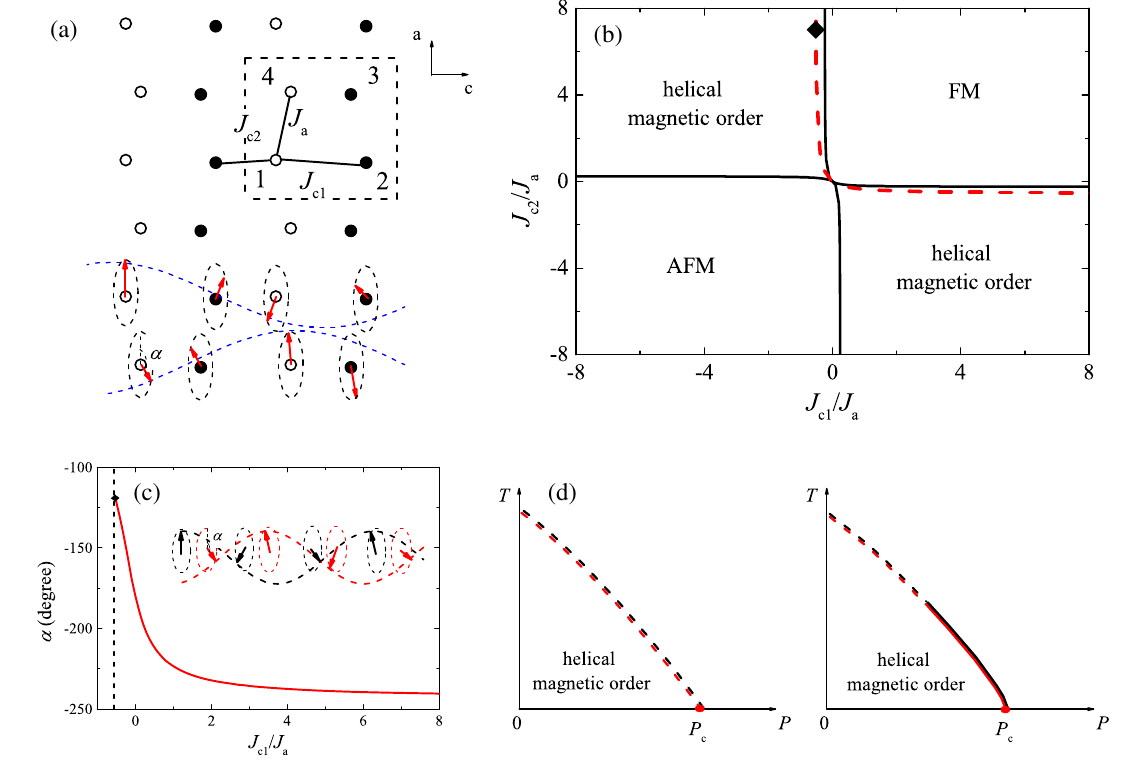
FIG. 7. Structure and magnetic phase diagram of CrAs. (a) Sketch of the CrAs lattice, with the b axis perpendicular to the paper plane. The open and closed symbols stand for the Cr atoms at layers b= 4 and 3 b= 4 , respectively. Each unit cell consists of four Cr atoms, labeled 1 through 4. The magnetic ground state is studied in a Heisenberg model [33] with exchange couplings up to fourth nearest- neighbor pairs of Cr, J , J , J , and J , where J (not shown) couples the magnetic moments of the same sublattice in nearest-neighbor a b c 1 c 2 b unit cells along the b axis. The arrows label the spin pattern associated with the double helical magnetic order. (b) Ground-state magnetic phase diagram of the model for CrAs. FM and AFM refer to ferromagnetic and antiferromagnetic states, respectively. The AFM state has an ordered wave vector Q ¼ ð 0 ; 0 ; 0 Þ , but the spins are staggered within each unit cell. The double helical magnetic order has a propagating wave vector Q ¼ ð 0 ; 0 ; δ Þ . The phase boundaries among the three phases are separated by two hyperbola, marked by solid curves. The red dashed line is a curve with fixed helical wave vector δ ¼ 0 . 353 · 2 π =c , and the diamond shows the position of the state with magnetic phase angle α ¼ − 120 °. (c) Evolution of the phase angle α for the double-helical order (illustrated in the inset) with J =J along the fixed δ ¼ 0 . 353 · 2 π =c curve in panel (b). (d) Two possible scenarios of the structural (black curve) and magnetic (red c 1 a curve) phase transitions in CrAs under pressure. The dashed and solid curves refer to first- and second-order transitions, respectively. The structural and magnetic transitions are always coupled together. They are first order at low pressures. With increasing pressure, they can either remain first order (left panel) or become second order (right